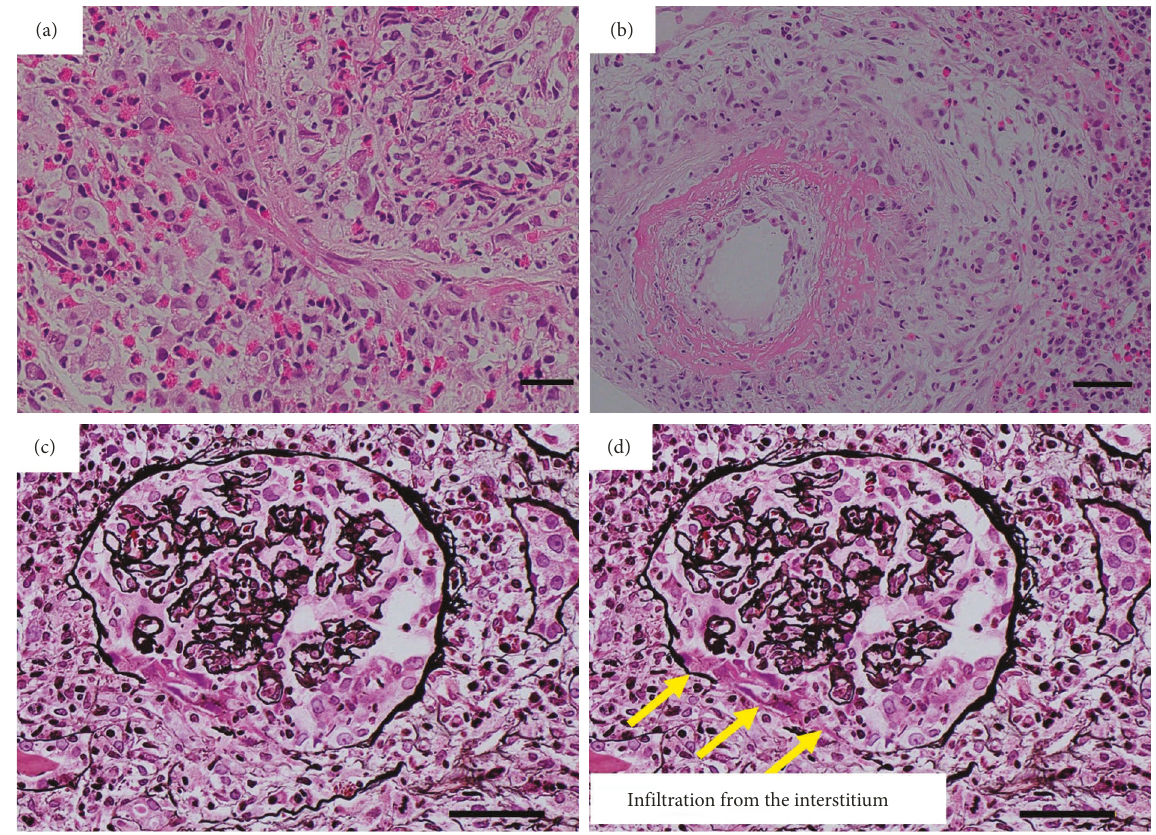
Figure 1: (a) Renal biopsy showing remarkable infiltration of eosinophils in the interstitium of the kidney (scale bar:100 μ m). (b) Fibrinoid necrosis visible in the interlobular arteries of the kidney (scale bar: 50 μ m). (c) One glomerulus, showing glomerular crescent formation (scale bar: 50 μ m). (d) Rupture of the glomerular basement membrane in this glomerulus, which appears to have spread from outside of the glomerulus; the yellow arrows indicate infiltration from the interstitium (scale bar: 50 μ m). A B: haematoxylin and eosin staining, C D: periodic acid methenamine silver